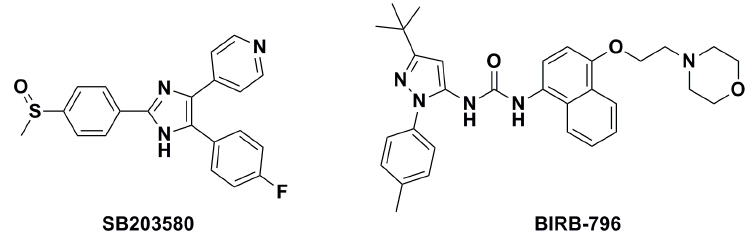
Figure 1. Structures of SB203580 and BIRB-796.